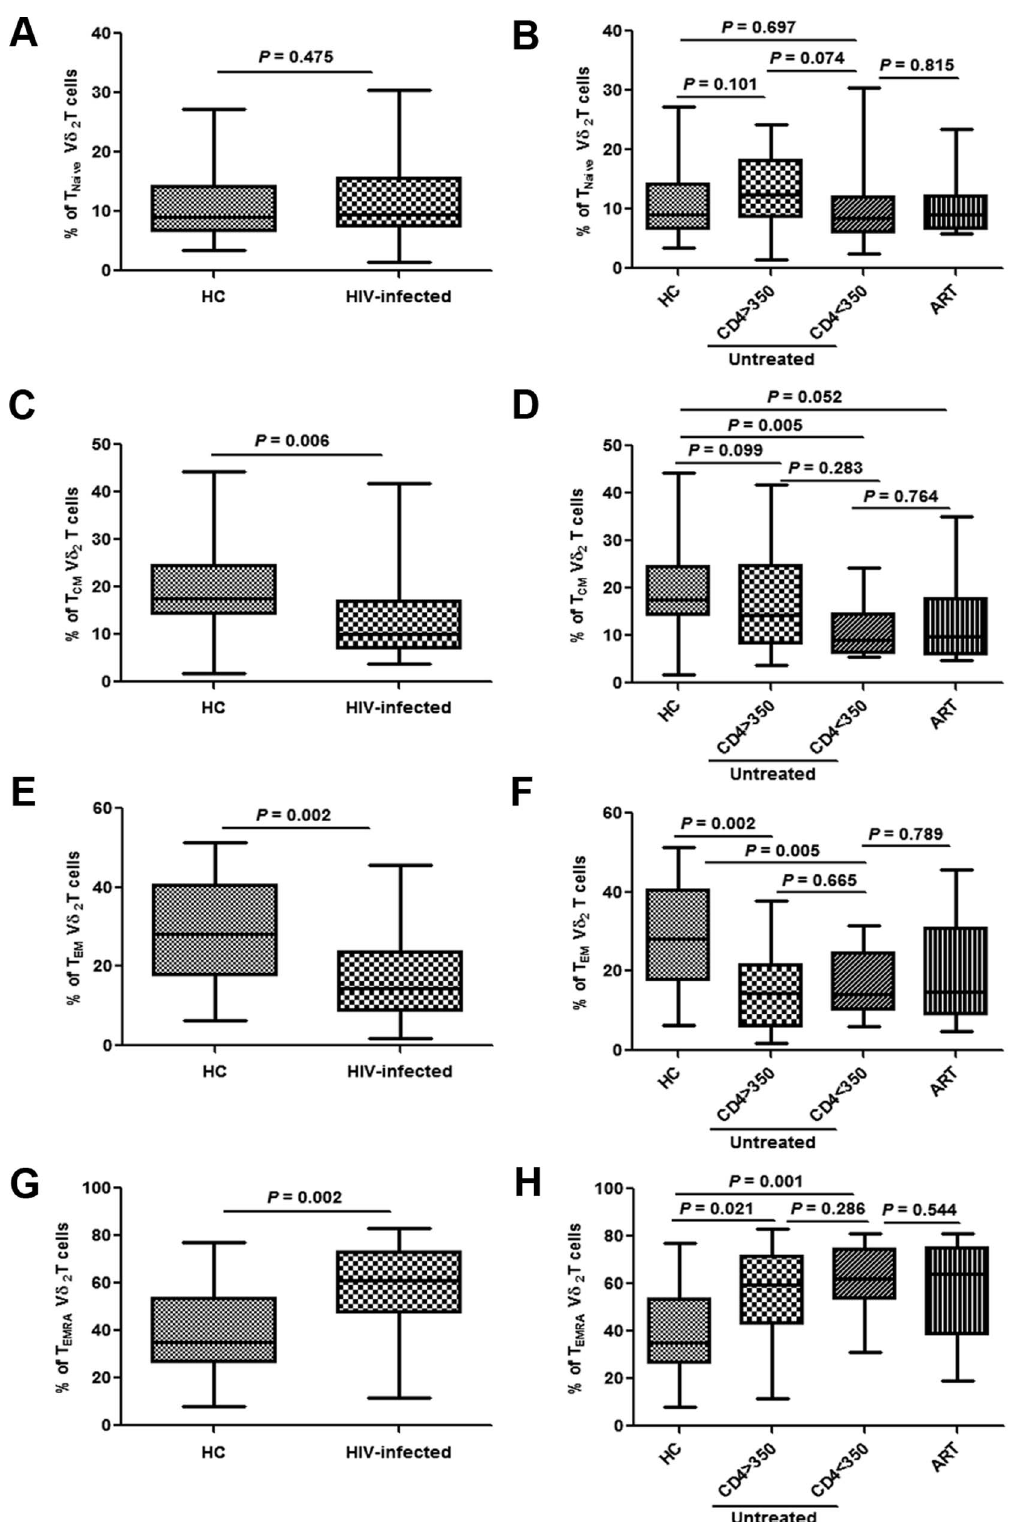
Figure 2. Changes in subpopulations of V d 2 cd T cells in acutely HIV-infected patients. Frequencies of Tnaı¨ve, TCM, TEM and TEMRA cells were analyzed in healthy controls (HC) and acutely HIV-infected subjects at baseline ( A, C, E, G ). The patients were then subdivided based on the administration of antiretroviral therapy (ART) and CD4 levels ( , or . than 350/ m L). The frequencies were re-analyzed and compared with HC ( B, D, F, H ).